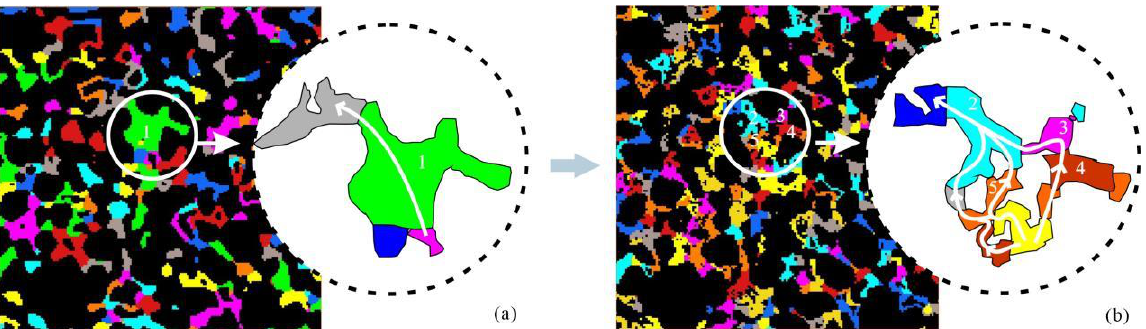
Figure 6. Comparison of pore water number before ( a ) and after ( b ) the formation of hydrates in two-dimensional X-CT images. Pore water is separated into lots of pores according to the topological connection relationship between pore water molecules. A pore is divided into five pores which leads to a greater coordination number and more tortuous paths of pore water.